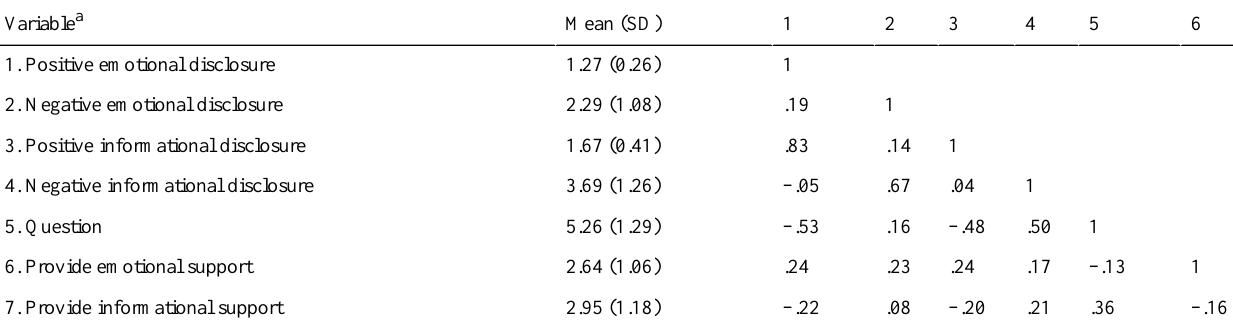
Table 6. Descriptive statistics and correlations among constructs using machine learning (N=58,357 discussion threads).